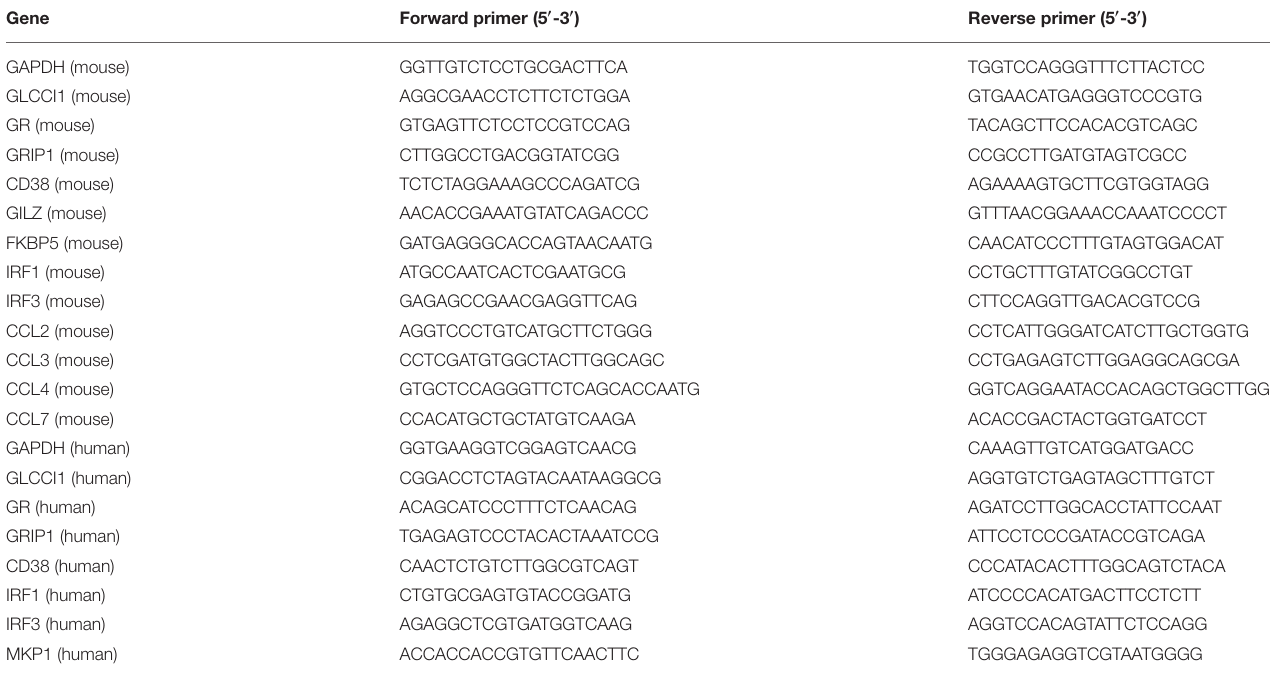
TABLE 1 | Sequences of target genes for real-time